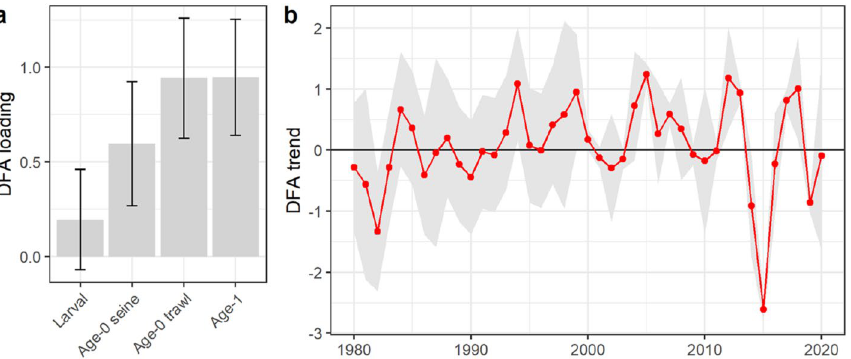
Figure 3. Dynamic Factor Analysis (DFA) results for shared trend in field observations of pollock recruitment, 1981–2020. ( a ) Time series loadings and 95% CI. ( b ) Shared trend in variability, with 95% CI. Positive values of the DFA trend in ( b ) can be interpreted as an increase in an unobserved process (e.g. pollock recruitment) that shows a positive relationship with the three time series in ( a ) with CIs for loadings that do not include